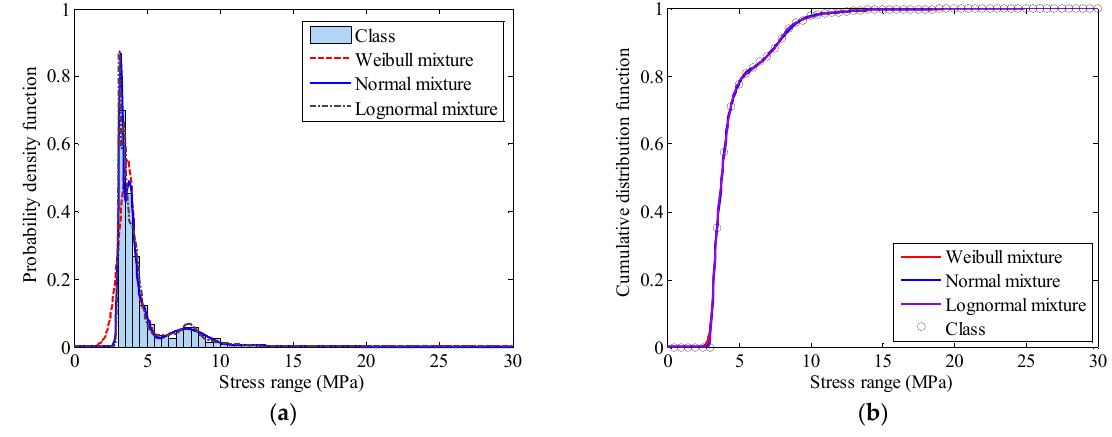
Figure 11. Distribution function of stress range: ( a ) Finite mixture PDFs; ( b ) Finite mixture CDFs. Table 1. Estimated mixture parameters of component distributions.